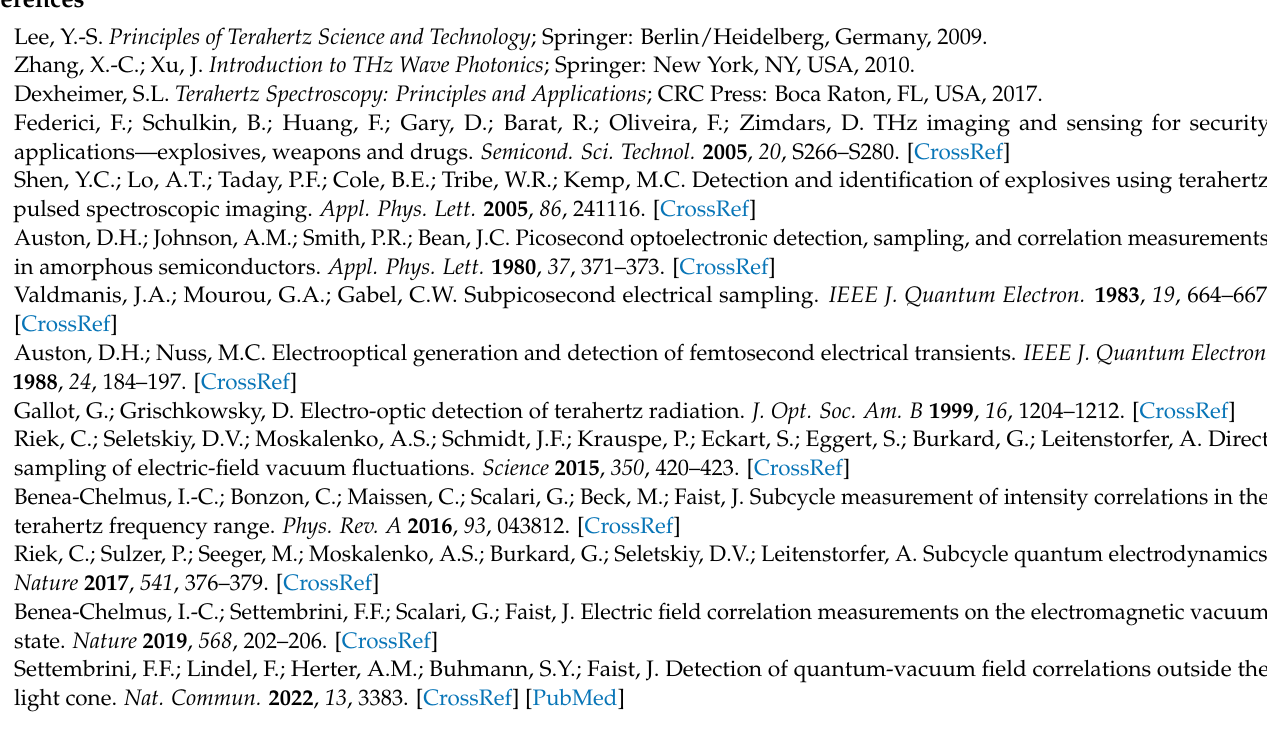
Figure S2: Theoretical analysis of the standard deviation and sensitivity; Figure S3: Experimental data statistical properties; Figure S4: Theoretical analysis of the expected measurement sensitivity including losses. References [37–39] are cited in Supplementary